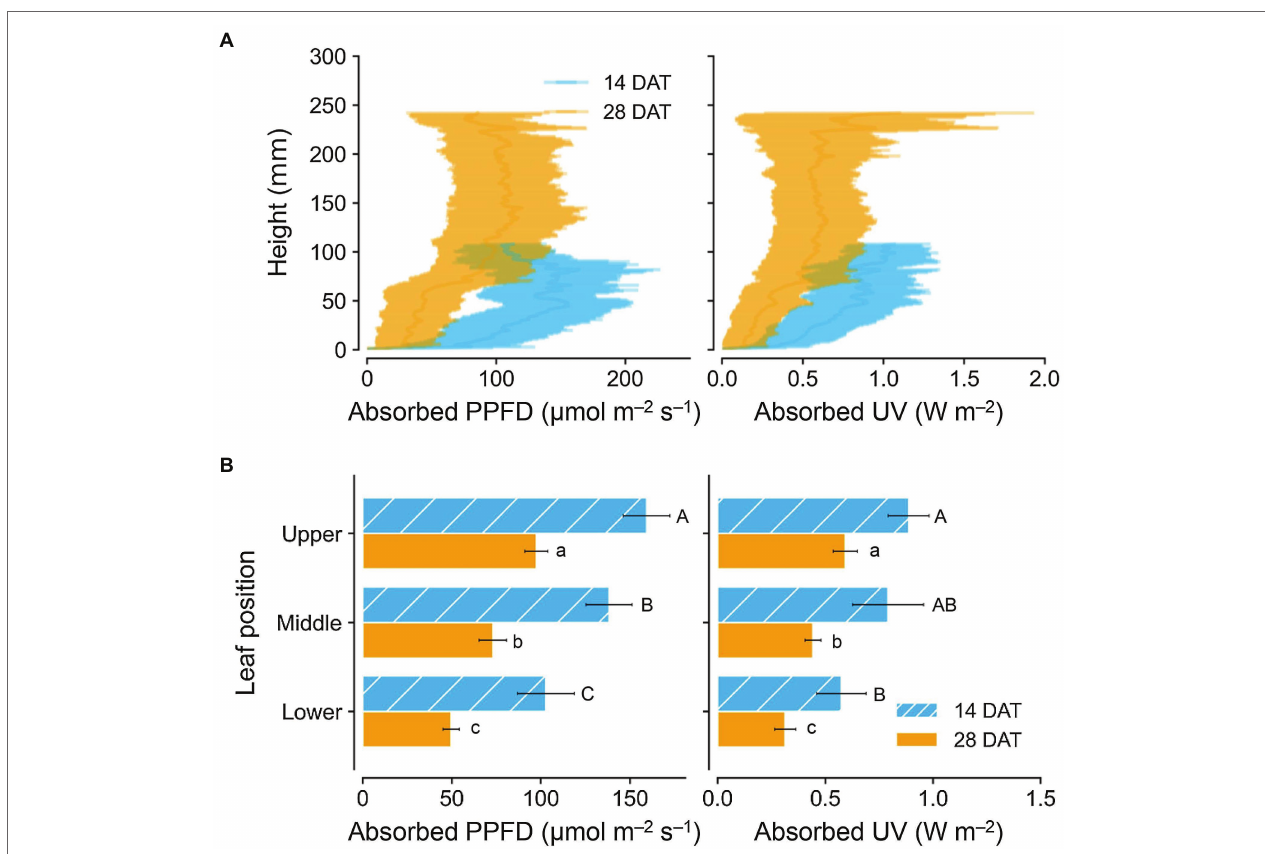
FIGURE 4 | Vertical distributions of light interception on kales according to plant heights (A) and leaf positions (B) at 14 and 28 days after transplanting (DATs). Each light interception represents the photosynthetic photon flux density (PPFD) absorbed at 400–700 nm and UV absorbed at 250–400 nm. Vertical vars indicate the standard error of mean ( n = 2; average of 12 and 6 plant models for 14 and 28 DATs, respectively). Different letters represent significant differences between leaf position at p < 0.05 by two-way ANOVA and Tukey’s HSD